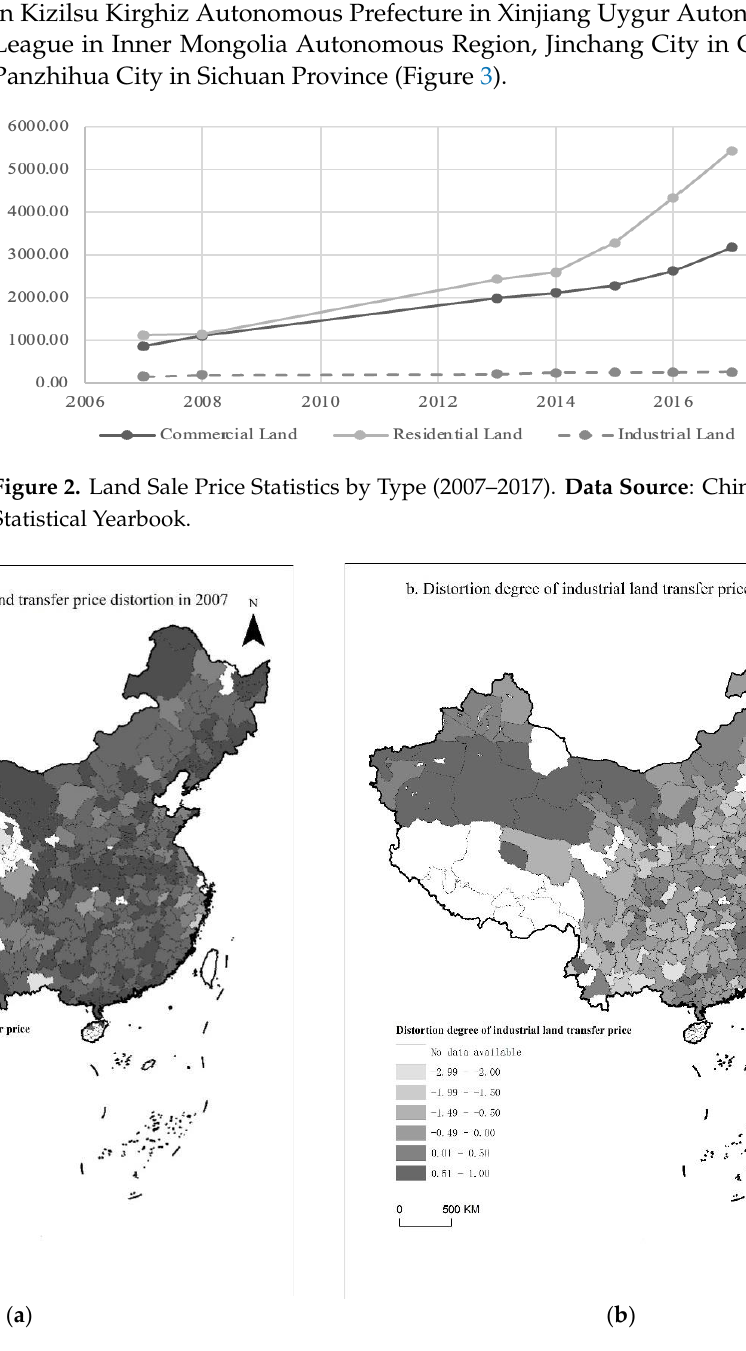
Figure 3. Spatial evolution of the degree of distortion in the price of industrial land transfers (2007 – 2017). Note. The analysis unit is the national prefecture-level administrative